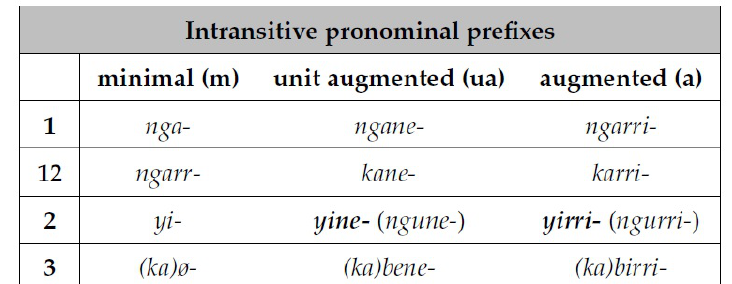
Table 7. Second person free